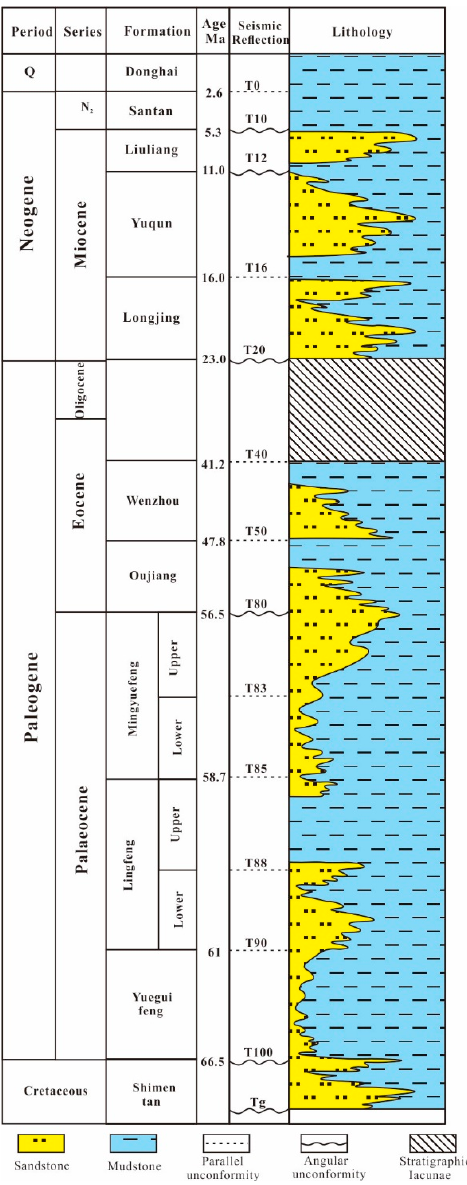
Figure 2. Stratigraphic units of the Paleocene in the Lishui Sag (modified after [51]).